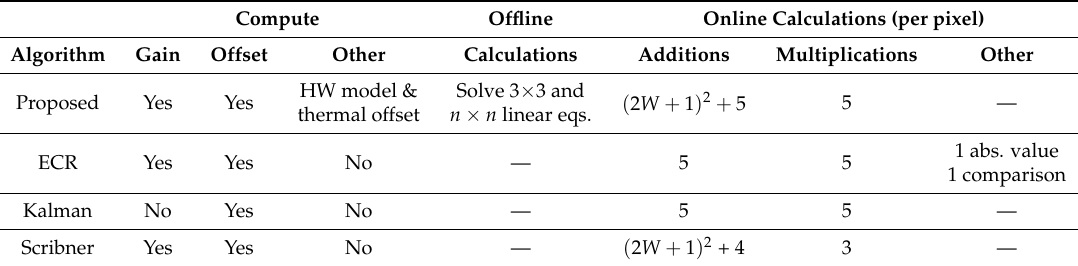
Table 1. Parameters and calculations perfomed by each NUC algorithm. ( 2 W + 1 ) × ( 2 W + 1 ) is the window size, and n is the order of the Hammerstein-Wiener (HW)